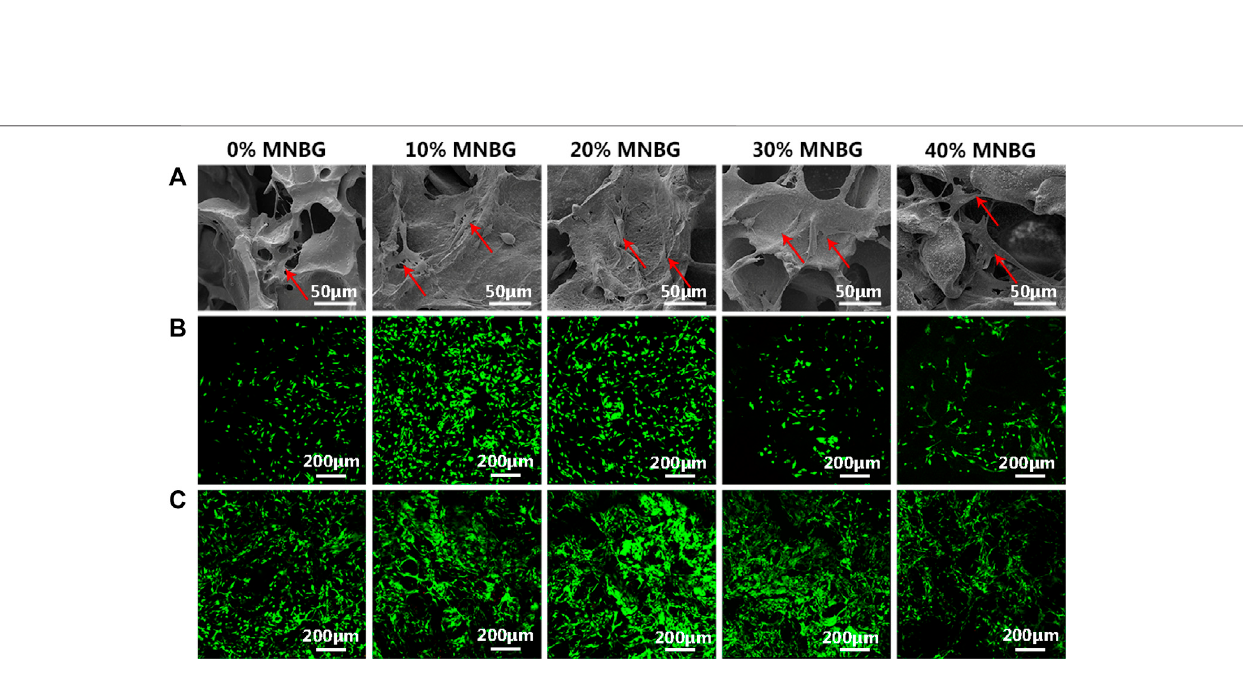
FIGURE 5 | Cell attachment and cell viability evaluation on scaffolds. (A) SEM images showing the mBMSCs attachment and spreading at day 1 (Red row in SEM images). (B,C) Cell viability detected by Live-Dead assay suggesting the good cell viability on the surface of scaffolds at (B) day 1 and (C) day 5. Green represents living cells and red represents dead